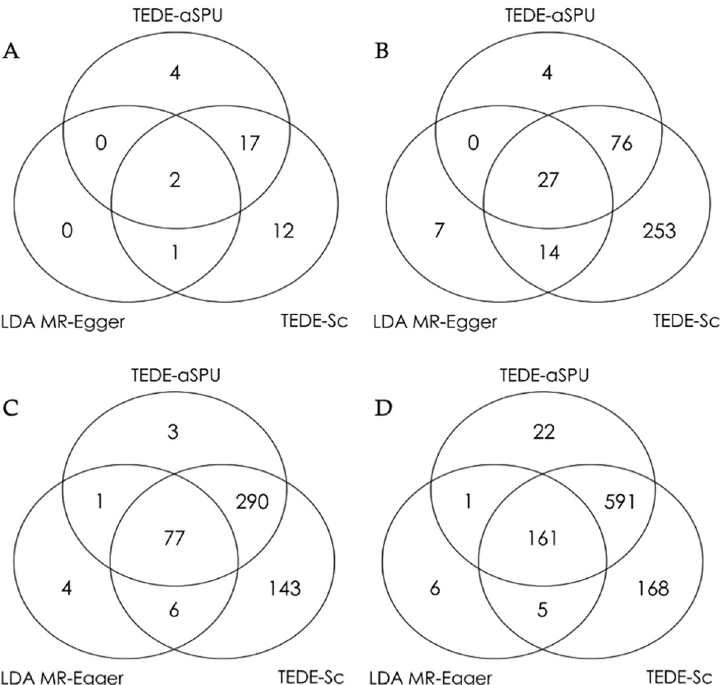
Fig 2. Numbers of significant loci with direct effects. Significance threshold: 0.05/#loci. A: AD as outcome (3611 loci with 49225 SNPs). B: SCZ as outcome (3611 loci with 49225 SNPs). C: LDL as outcome (2010 lipid data; 4267 loci with 58382 SNPs). D: LDL as outcome (2013 lipid data; 4267 loci with 58382 SNPs).